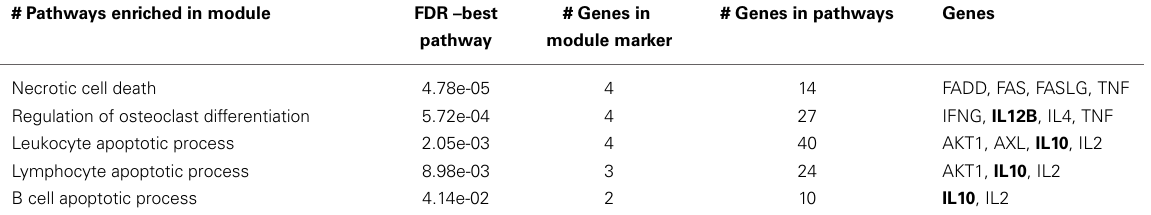
Top: Gene and Module Markers comparisons under various treatments. Mid: Annotation of Conserved module markers between DAC and DAC − TSA treatments. Annotation of Conserved module markers between TSA and DAC − TSA treatments. Bottom: Examples of annotated module markers specific to co-treatment (DAC + TSA). * Listed in bold font in the last column examples of extended genes, i.e., missing in the microarray but found connected in the network by the described method.